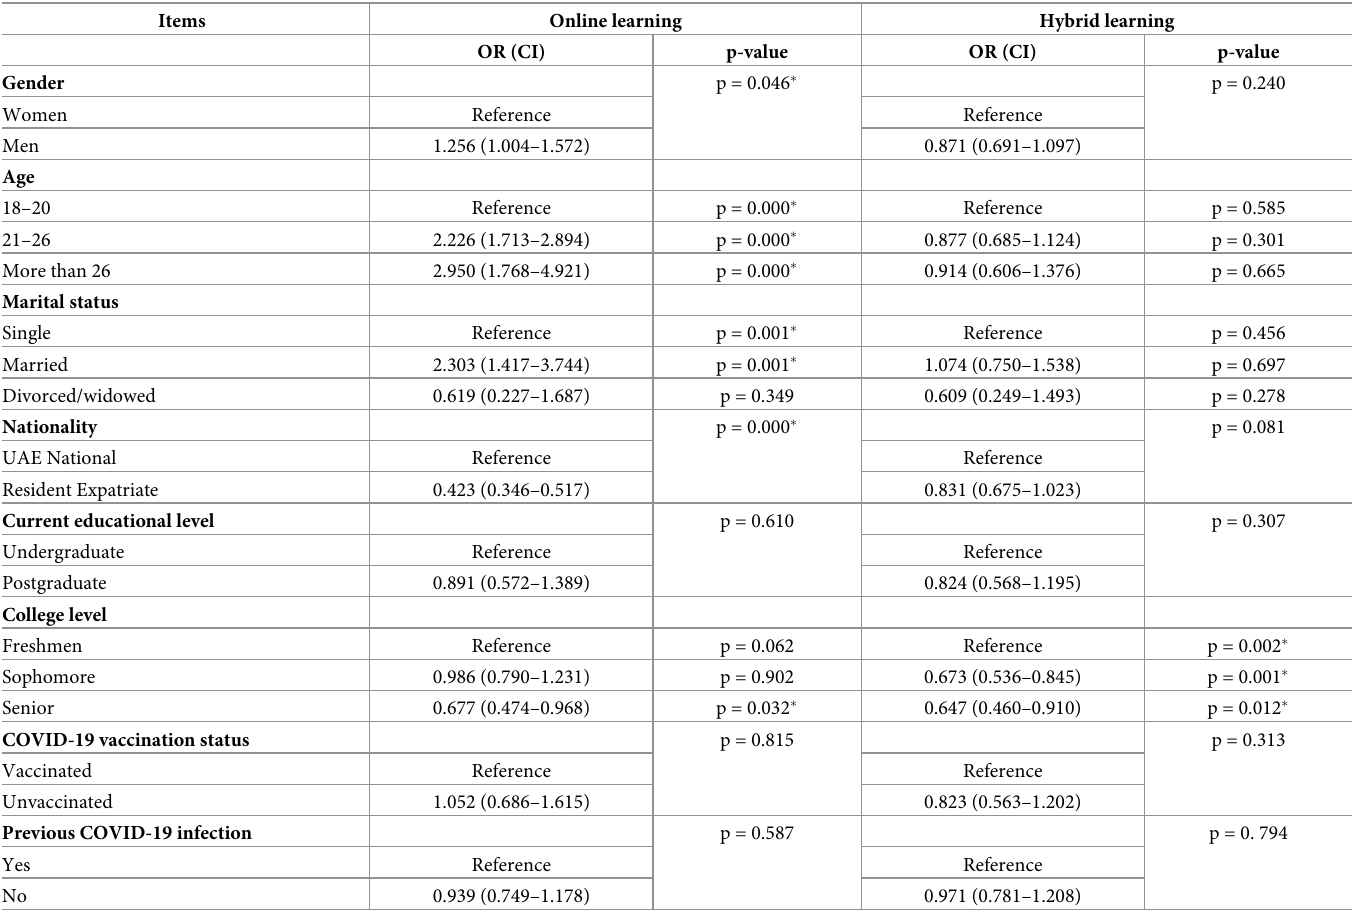
Table 3. Predictors of students’ perceptions of online and hybrid learning using logistic regression